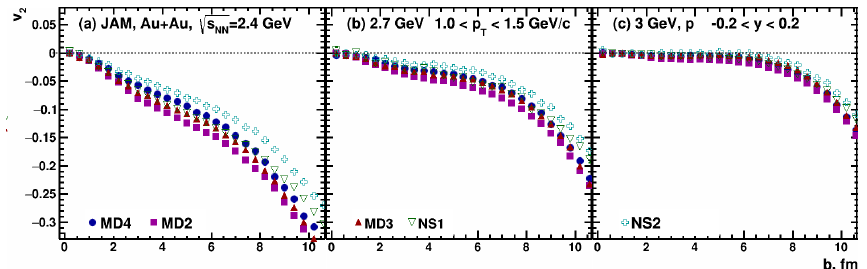
Figure 20. Impact parameter dependence of elliptic flow v 2 of protons in the transverse momentum interval 1.0 < p T < 1.5 GeV/c at mid-rapidity | y cm | < 0.2 from Au + Au collisions at beam energies √ s NN = 2.4 GeV (panel ( a )), 2.7 GeV (panel ( b )), and 3.0 GeV (panel ( c )). Different symbols correspond to the different EOS implementations in the JAM model: soft momentum independent NS2 ( K 0 = 210 MeV), hard momentum independent NS1 ( K 0 = 380 MeV), soft momentum dependent MD4 ( K 0 = 210 MeV) and hard momentum dependent MD2 and MD3 ( K 0 = 380 MeV).